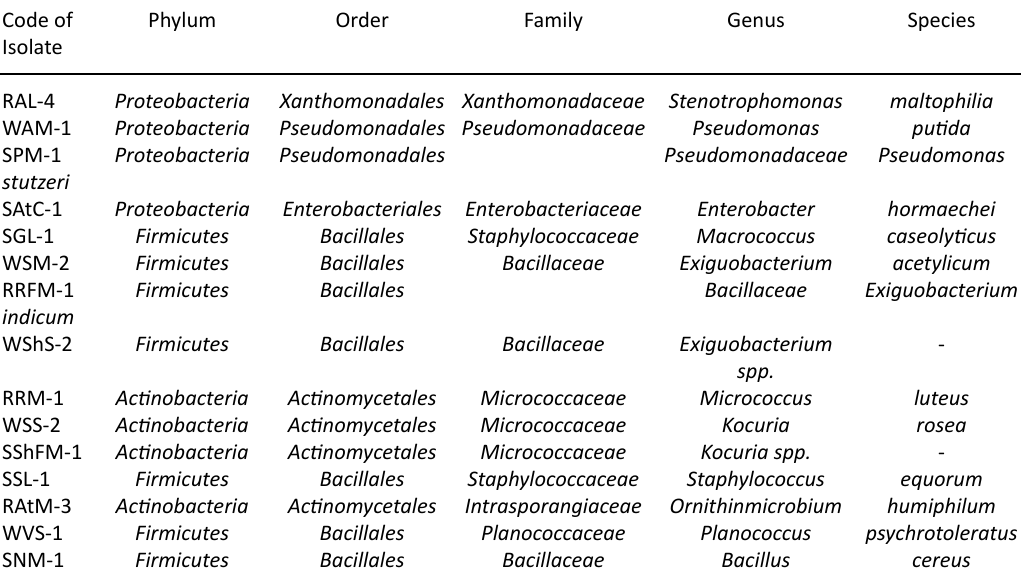
table 5. Identification of bacterial